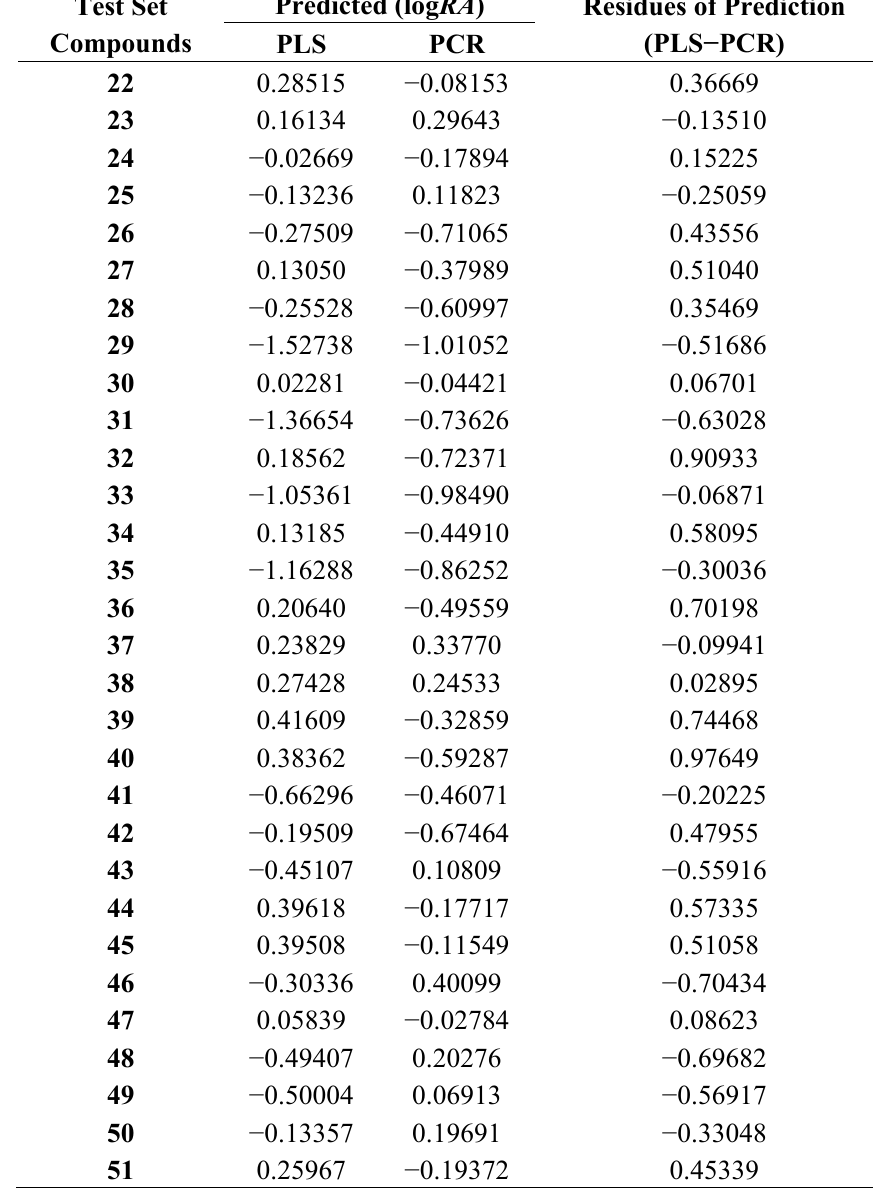
Table 7. Antimalarial activity predicted (log AR) by PCR and PLS models for the test set compounds and residues of prediction between